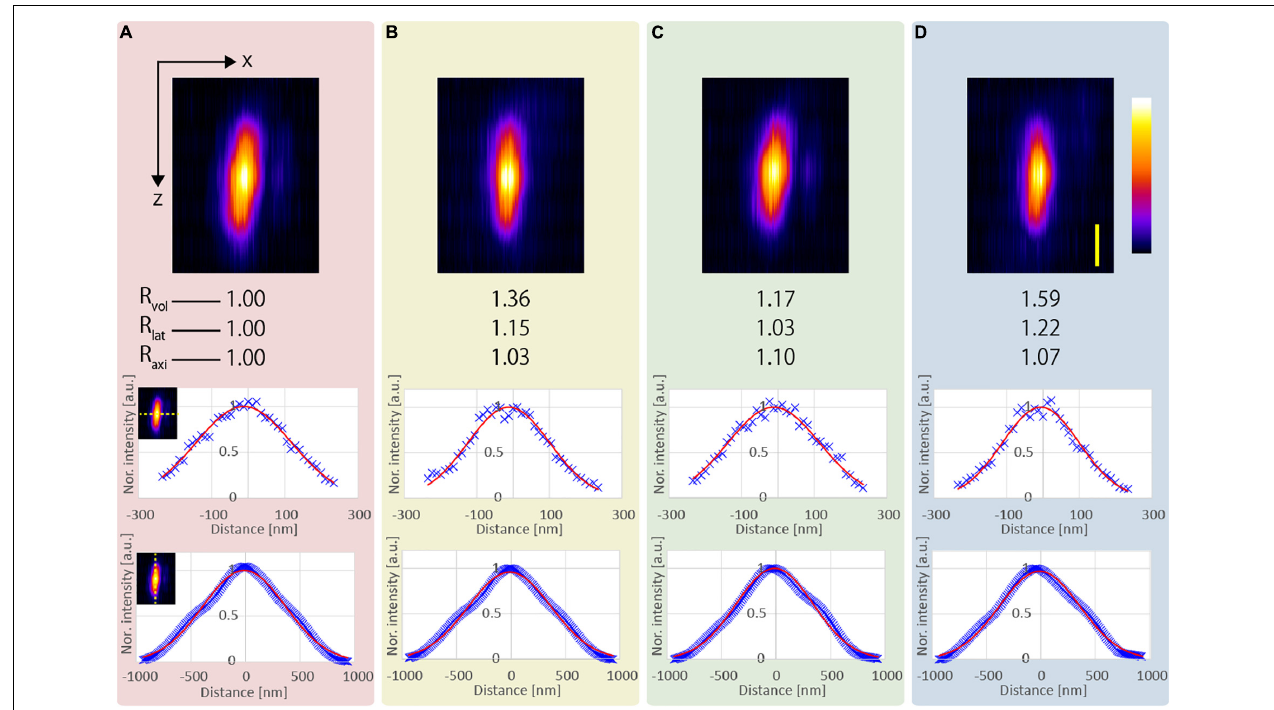
FIGURE 3 | Observation results of a fluorescent nanodiamond particle existing near the surface of the epoxy resin obtained using the (A) CP, (B) APV, (C) AMCP, and (D) AMAPV excitation beams. Top: the x-z projected images of the nanodiamond. Middle: line profiles and Gaussian fittings in the lateral direction. Bottom: line profiles and Gaussian fitting results in the axial direction. The excitation beam intensity under the objective lens was (A) 18.7, (B) 22, (C) 25.7, and (D) 28.2 mW. Scale bar: 500 nm.